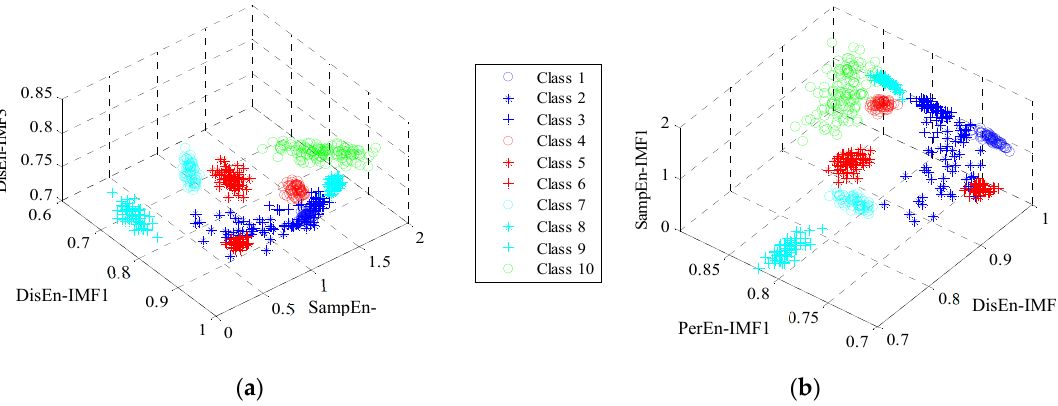
Figure 5. Scatter plots for nonlinear entropy features of the ten bearing fault classes: ( a ) selected discriminative features and ( b ) DisEn, PerEn, and SampEn of IMF1.